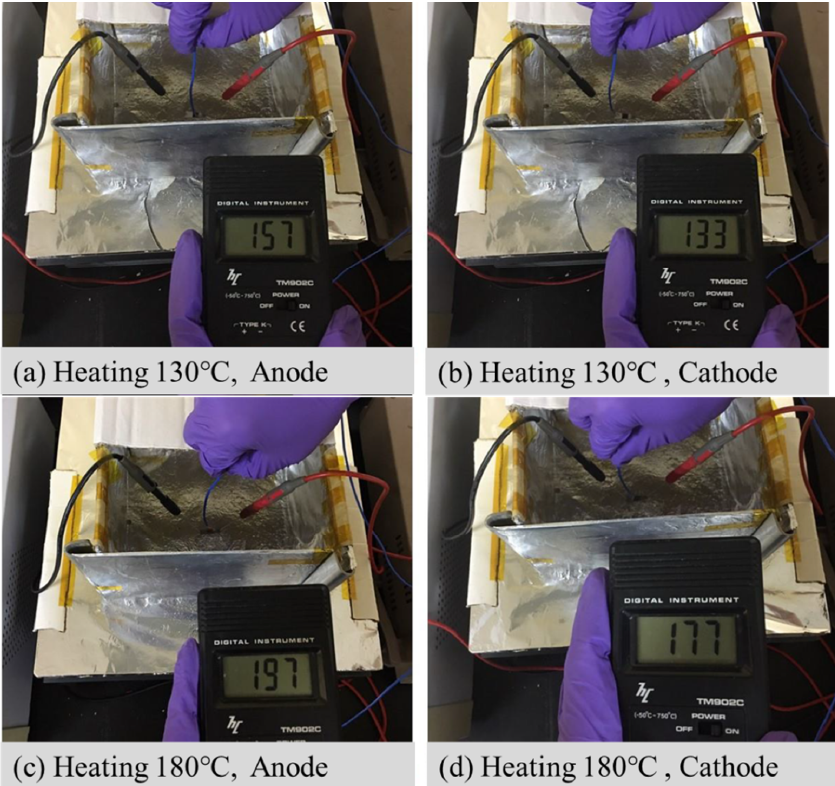
Figure 15. The temperature read-out of the sample located at the ( a ) anode heated at 130 °C with input current; ( b ) cathode heated at 130 °C with input current; ( c ) anode heated at 180 °C with input current; ( d ) cathode heated at 180 °C with input current.